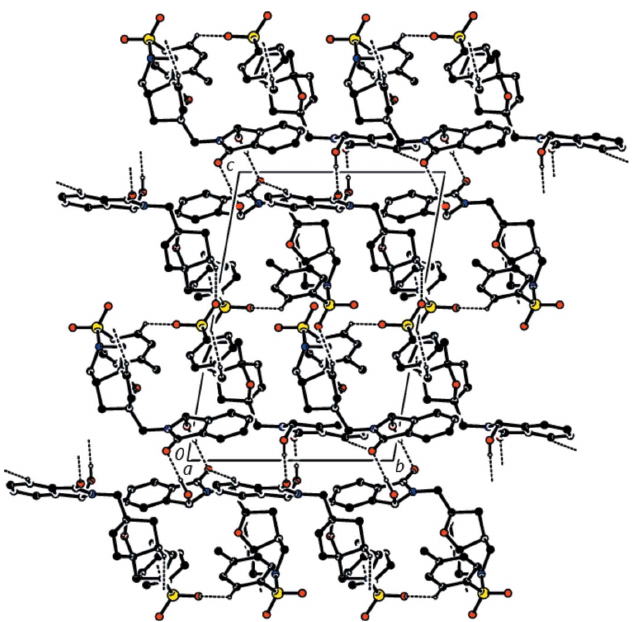
Figure 4 A view of the intermolecular C—H (cid:3)(cid:3)(cid:3) O and O—H (cid:3)(cid:3)(cid:3) O interactions in the crystal structure of the title compound 3 .